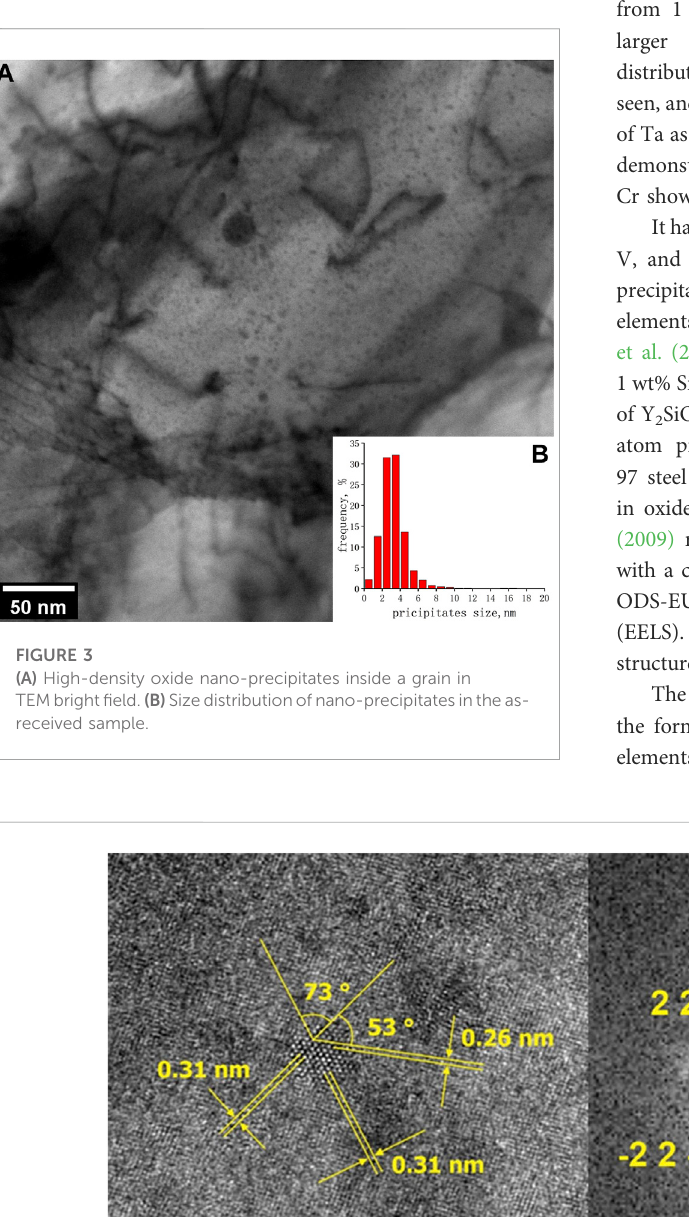
(FFT) image. A structure of Y 2 O 3 (PDF#01-075-3096) in the direction of (0 2 2) can be seen. The d-spacings of 0.26 and 0.31 nm accord with the d-spacings of (4 0 0), (2 2 2) in Y 2 O 3 , respectively, and the corresponding angles are 73 and 53 ° .